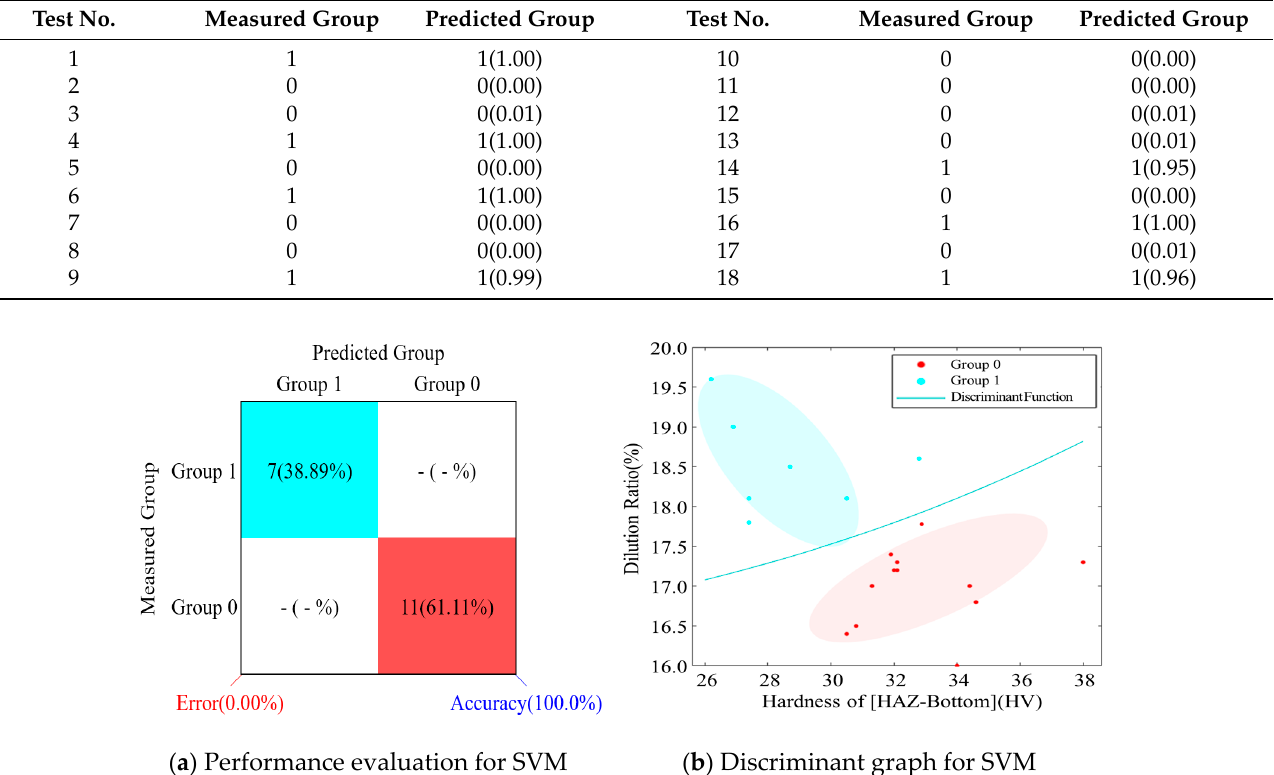
Figure 8. Weld joint hardening discriminant in fiber laser welding: ( a ) Performance evaluation for SVM and ( b ) Discriminant graph for SVM. Table 9. Learning data for discriminants of fiber laser welding quality.